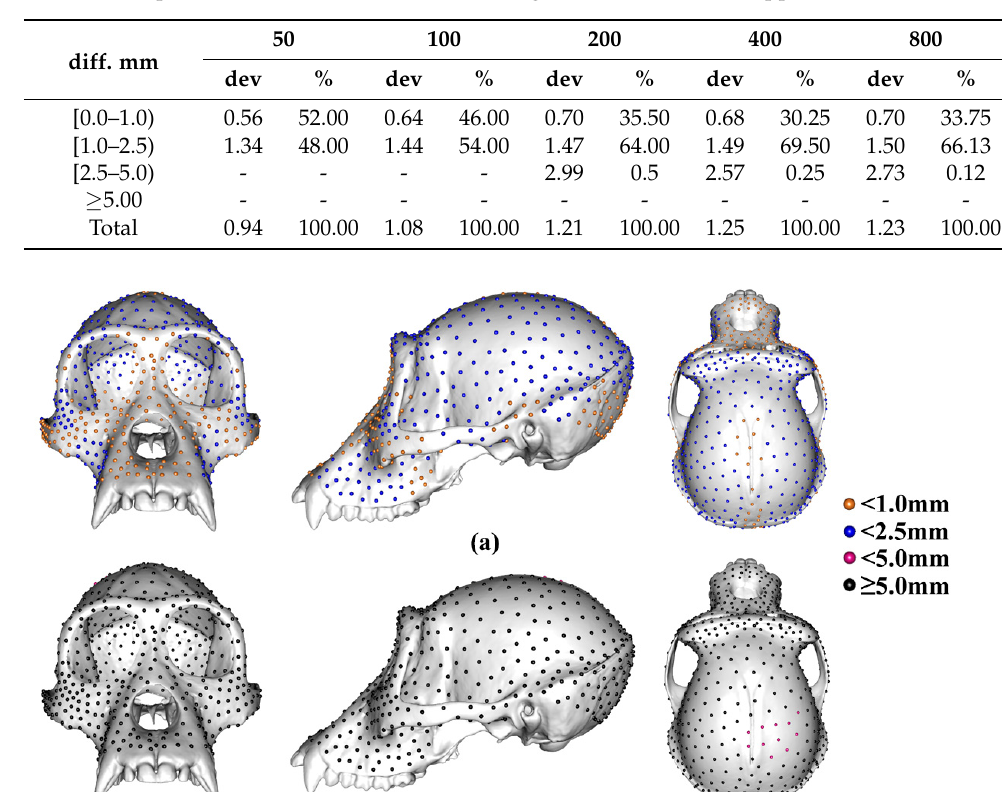
Table 1. Comparison of semilandmarks from sliding TPS and TPS&NICP approaches.